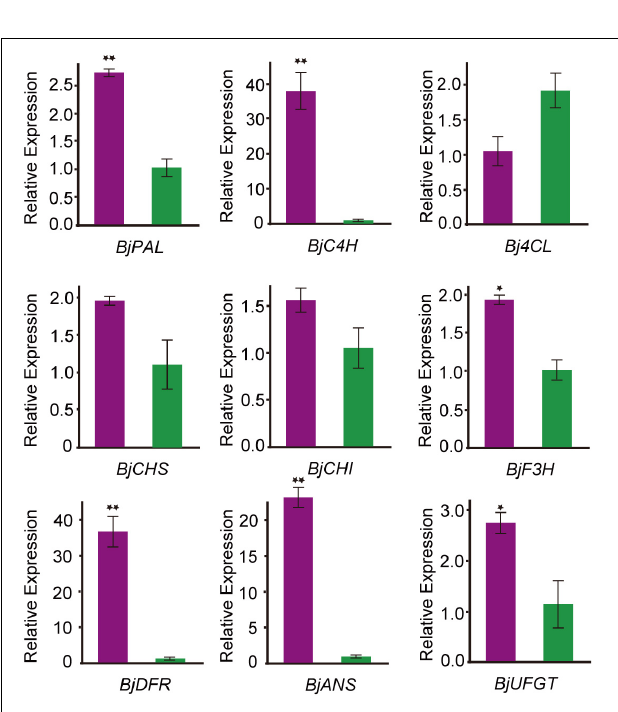
FIGURE 5 | qRT-PCR analysis the expression pattern of genes involved in anthocyanin biosynthesis B. juncea . The purple color represents transcript expression level of genes in ZiYi B. juncea with purple leaf. The green color represents transcript expression level of genes in LvYi B. juncea with green leaf. *Signifcantly diferent at P < 0.05; **Signifcantly diferent at P <